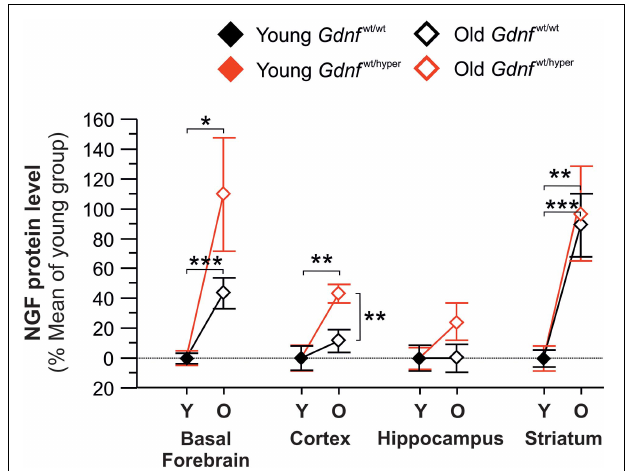
FIGURE 2 | Changes in the protein levels of NGF in the brain of young and old Gdnf wt / wt and Gdnf wt / hyper mice. NGF protein level was measured in the basal forebrain, cortex, hippocampus, and striatum of young (Y) and old (O) Gdnf wt / hyper and Gdnf wt / wt mice. The data are given as percent of mean values in young animals. The raw data is provided in the Supplementary File . n = 10 per group (young) and n = 8 per group (old). Data are presented as mean ± SEM. * p < 0.05; ** p < 0.01; *** p < 0.001.